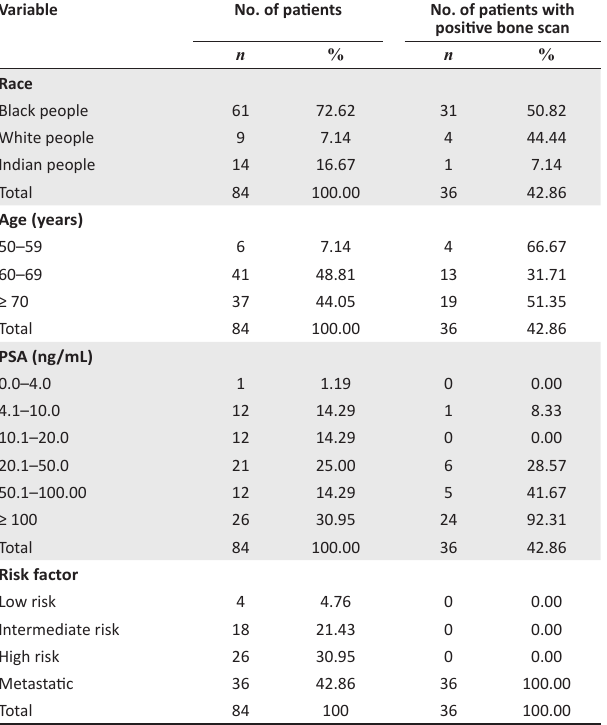
TABLE 1: Correlation of age and prostate-specific antigen (PSA) with bone scan findings. Variable No. of